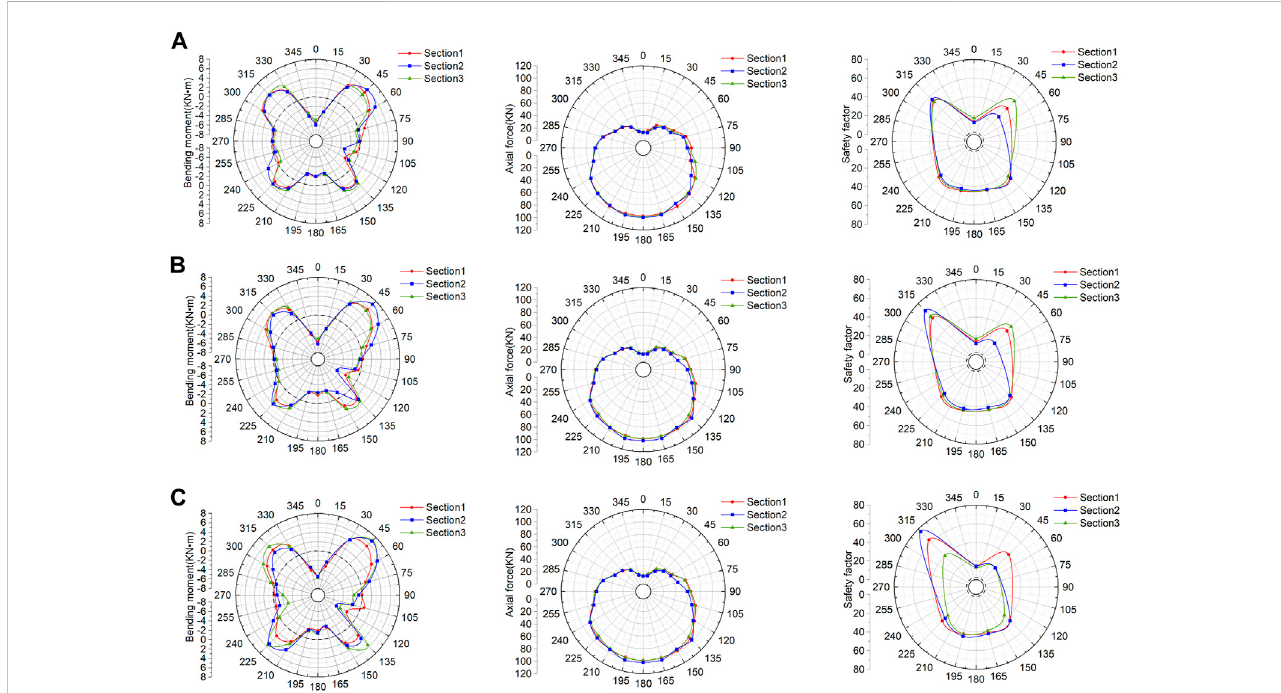
FIGURE 11 Bendingmoment,axialforce,andsafetyfactorofsections1,2,and3. (A) Thecutterheadisatpointa. (B) Thecutterheadisatpointb. (C) Thecutterheadis at point